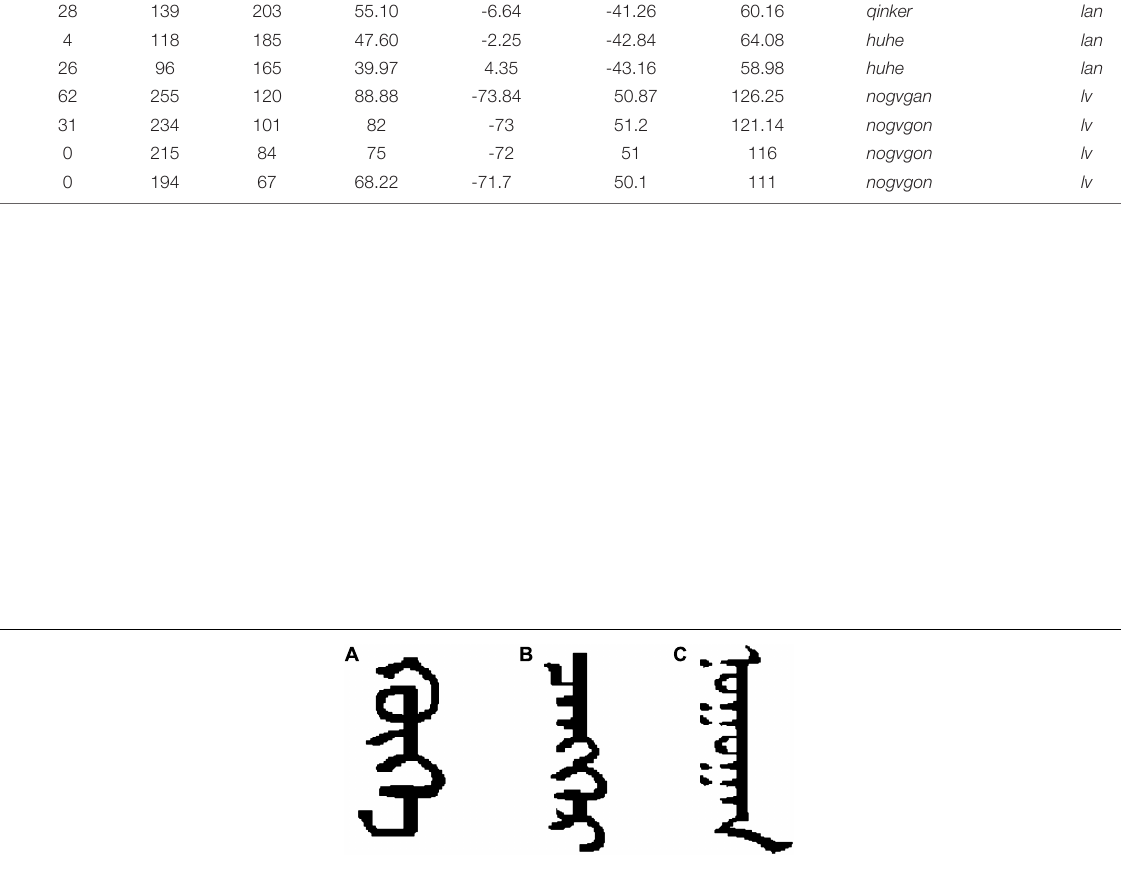
Frontiers in Psychology |